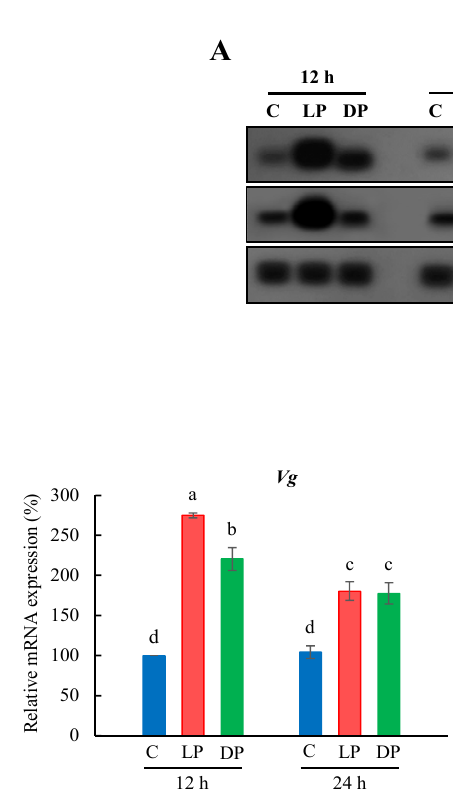
Figure 1. Expression profile of Vg and abaecin in the fat body of A. mellifera nurse bees fed with live or heat-killed P. larvae . ( A ) The expression of Vg and abaecin , as ascertained by northern blot analysis ( n = 7). β -Actin was used as an internal control to depict the total RNA loading amount. C, untreated controls; LP, feeding with live P. larvae ; DP, feeding with heat-killed P. larvae . 12 h and 24 h represent feeding time. ( B ) The relative levels of Vg and abaecin mRNAs represent the average band densities of the target genes normalized to the expression levels of the control (12 h). The bars represent the mean ± SD from three measurements. A one-way ANOVA test was used to determine the significant difference ( p < 0.05) with different lowercase letters (a–d).